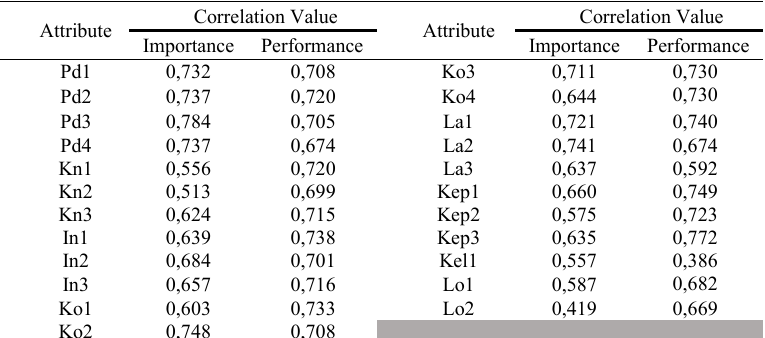
TABLE 4 V ALIDITY T EST R ESULTS FOR I MPORTANCE AND P ERFORMANCE